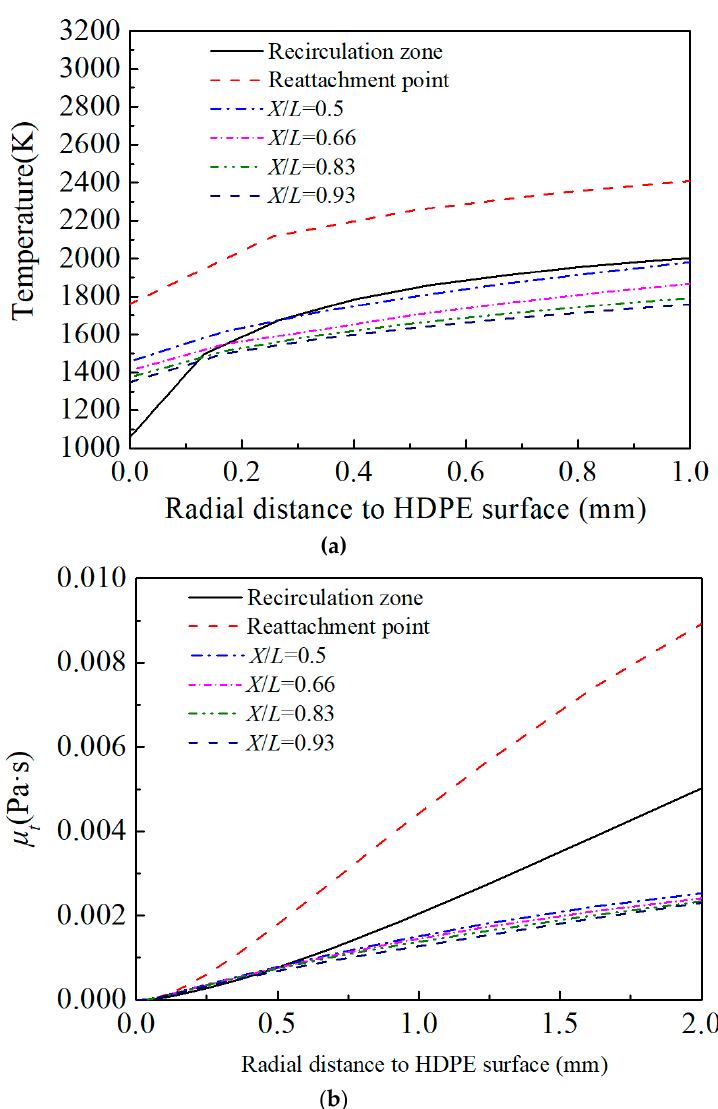
Figure 21. The profiles of local heat flux and regression rate along the solid surface. Energies 2019 , 12 , x FOR PEER REVIEW